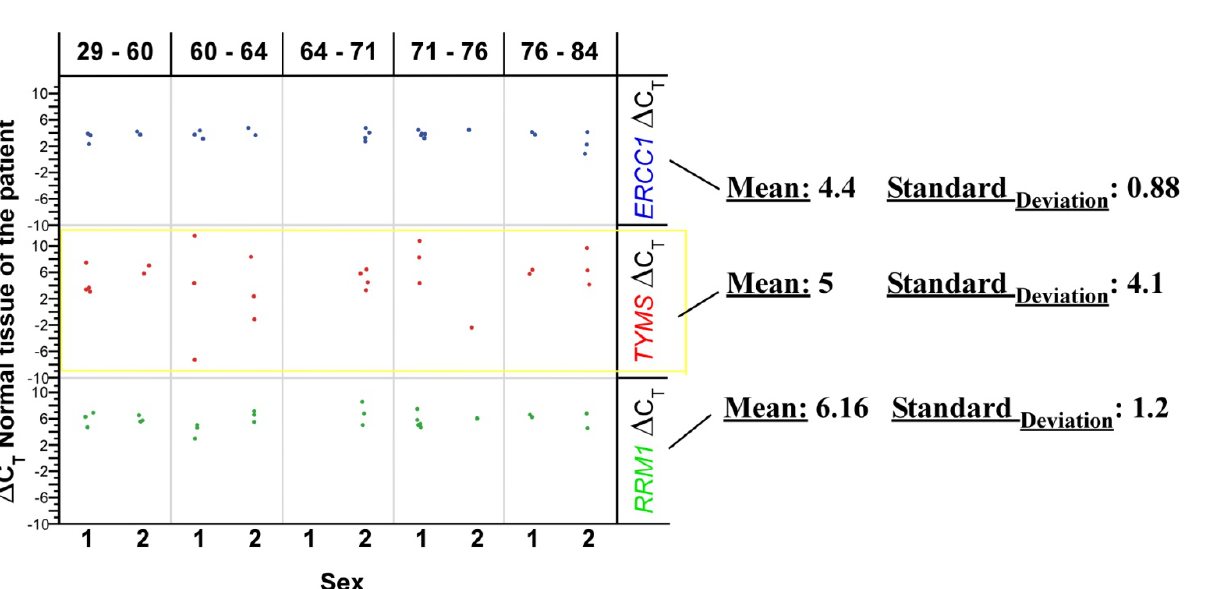
Figure 11. Differences in gene expression are not correlated with age or sex (1 = female; 2 = male). ERCC1 , TYMS and RRM1 assays show the same pattern of variances in gene expression. The ERCC1 and RRM1 expression profile seems to be more significantly correlated as compared to TYMS . TYMS is a little bit more variable in its gene expression among different individuals than ERCC1 and RRM1